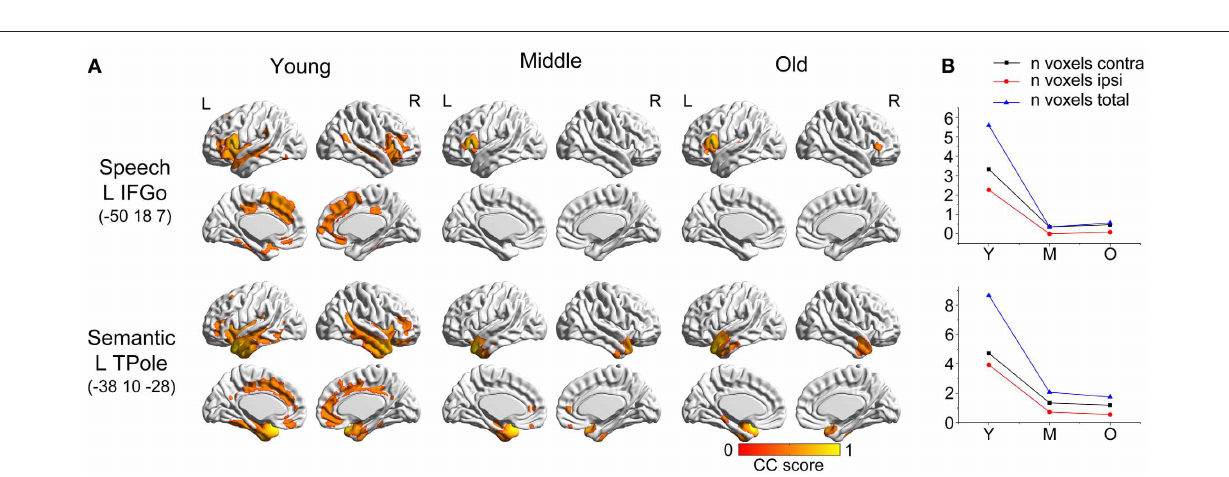
FIGURE 2 | Age-related changes in speech and semantic structural covariance networks.(A) Statistical maps of regions significantly correlated with the seed region in each group. The results are presented as correlation coefficient values ( P < 0 . 05, FWE corrected). (B) The plots of voxel counts by